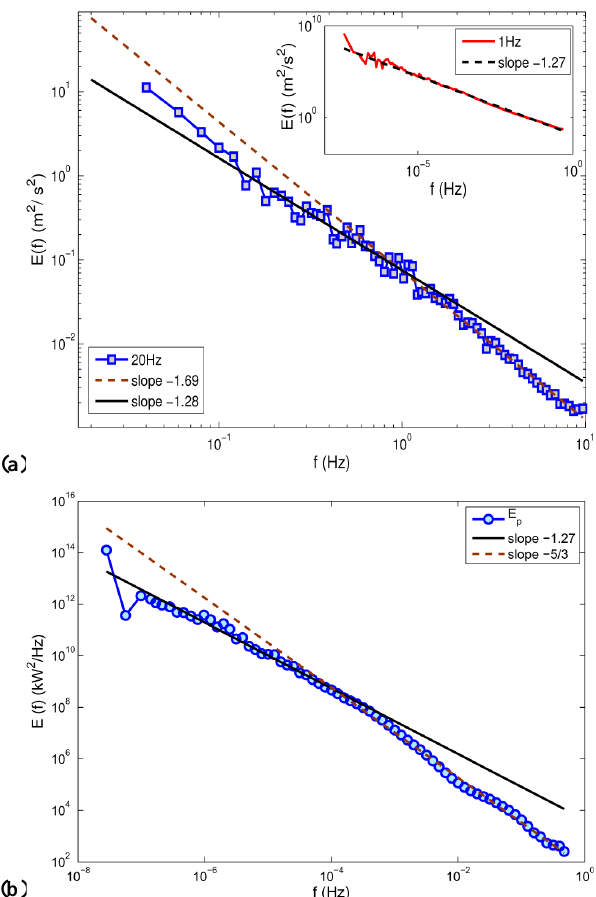
Fig. 3. The Fourier power spectra illustrating two scaling regimes: (a) averaged spectrum E v (f ) for the atmospheric wind speed sam- pled at 20Hz displaying a − 1.69 scaling for 1 6 f 6 10Hz and a − 1.28 scaling for f 6 1Hz. The inset shows that the Fourier spec- tra of wind atmospheric sampled at 1Hz display a − 1.27 scaling over seven decades. (b) Averaged spectrum E p (f ) for the aggre- gate power output, for which a crossover between a − 5 / 3 slope and − 1 . 27 slope is also